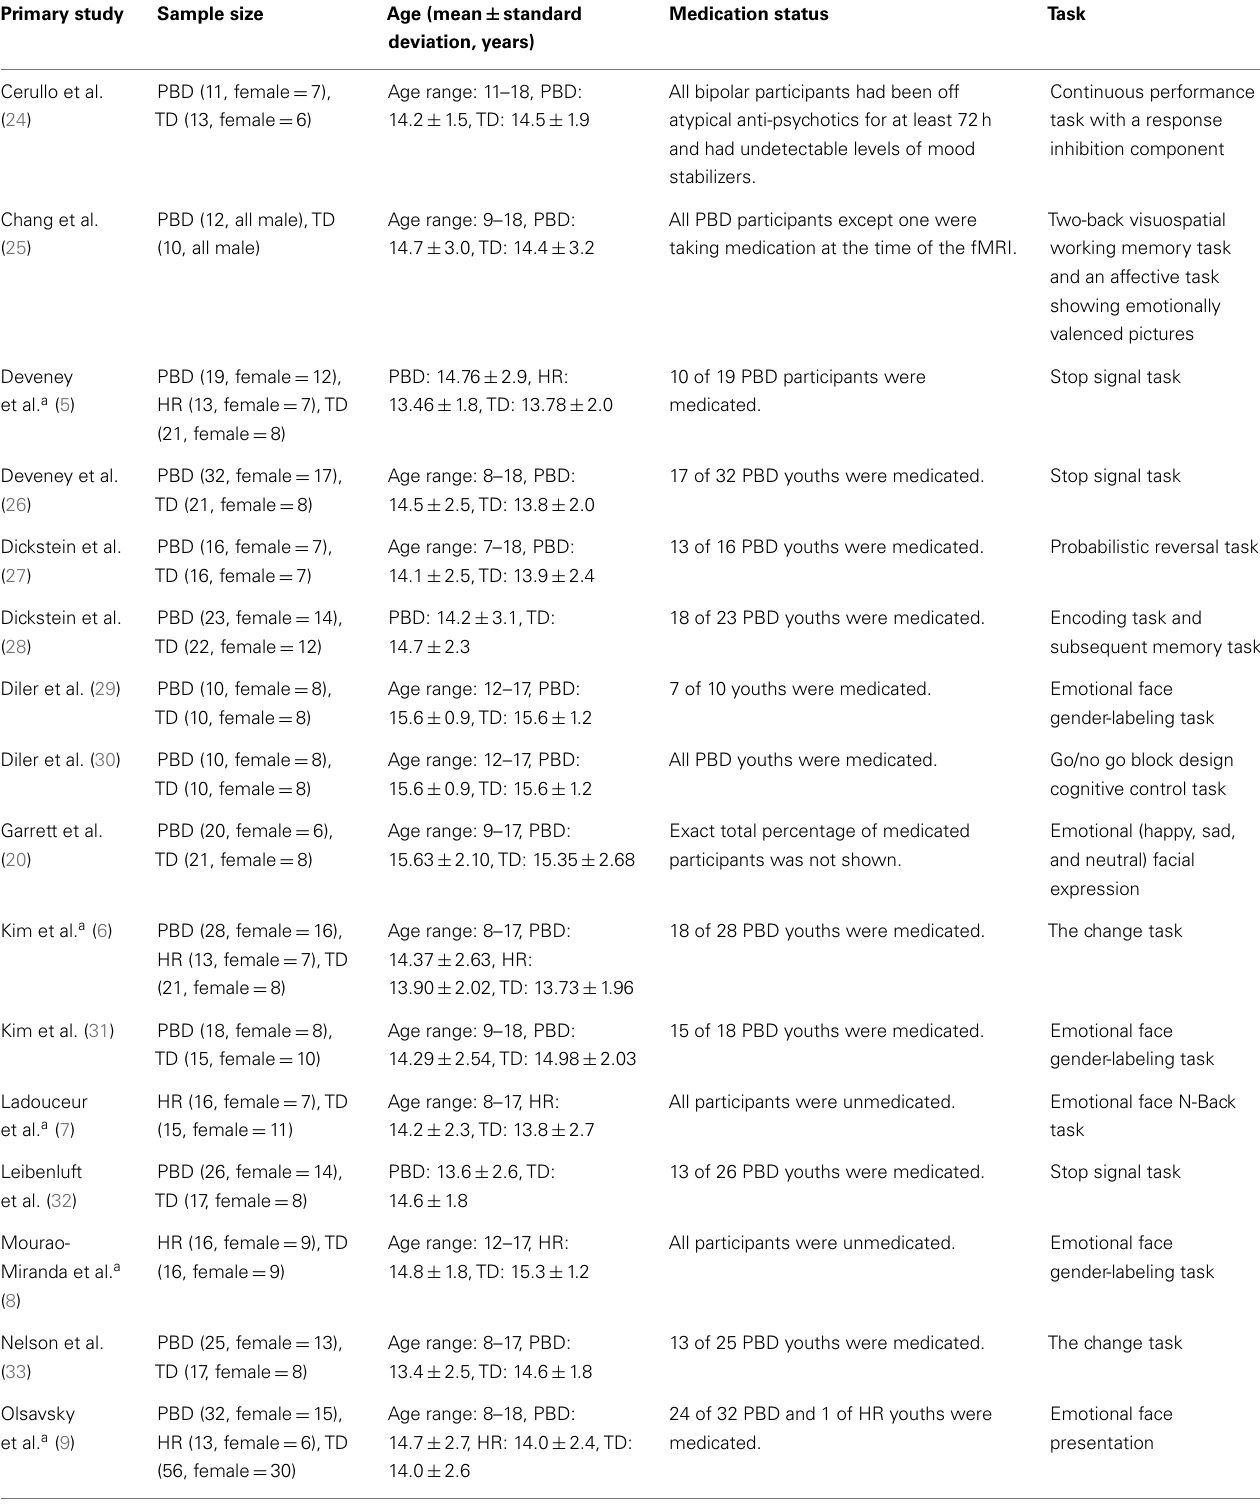
Table 1 | Primary fMRI studies of participants with pediatric bipolar disorder (PBD), those at high risk (HR) for PBD, and typically developing (TD): children included in meta-analysis